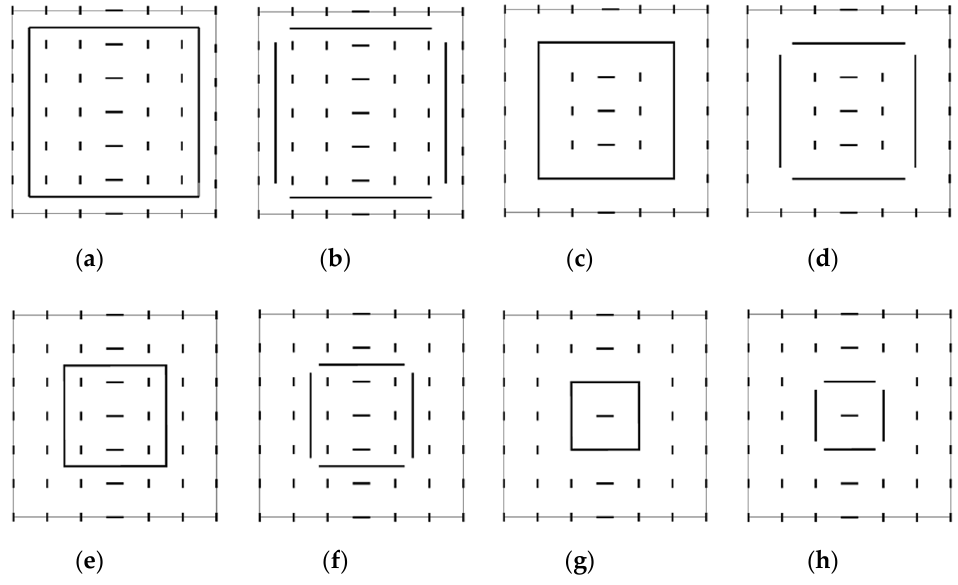
Figure 4. Building plans for third group of parametric study (with b/r = 2.45): ( a ) Building frequency ratio Ω = 1.5; ( b ) Building frequency ratio Ω = 1.4; ( c ) Building frequency ratio Ω = 1.3; ( d ) Building frequency ratio Ω = 1.15; ( e ) Building frequency ratio Ω = 1.1; ( f ) Building frequency ratio Ω = 1.0; ( g ) Building frequency ratio Ω = 0.85; ( h ) Building frequency ratio Ω = 0.7.